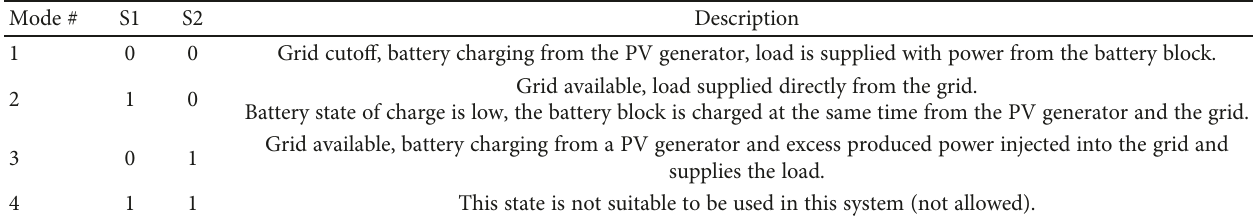
Table 1: Operating modes of the system.